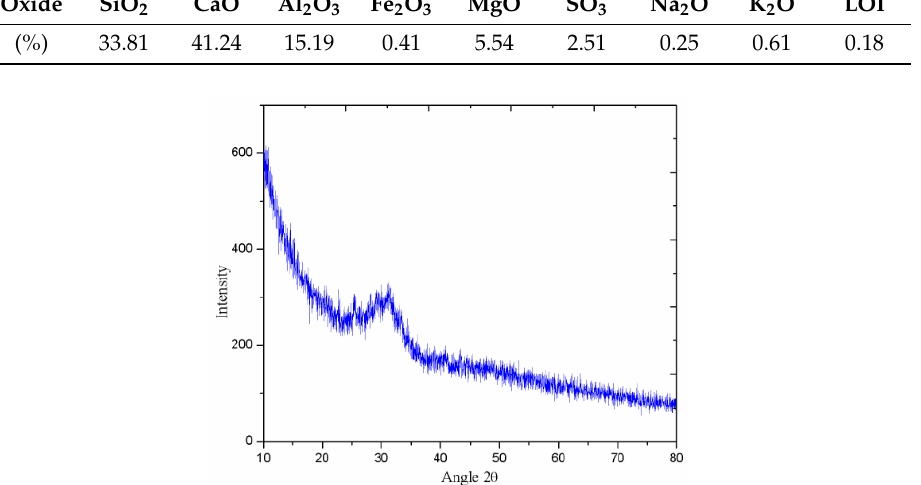
Figure 1. X ‐ ray diffraction (XRD) pattern of blast furnace slag. Figure 1. X-ray diffraction (XRD) pattern of blast furnace